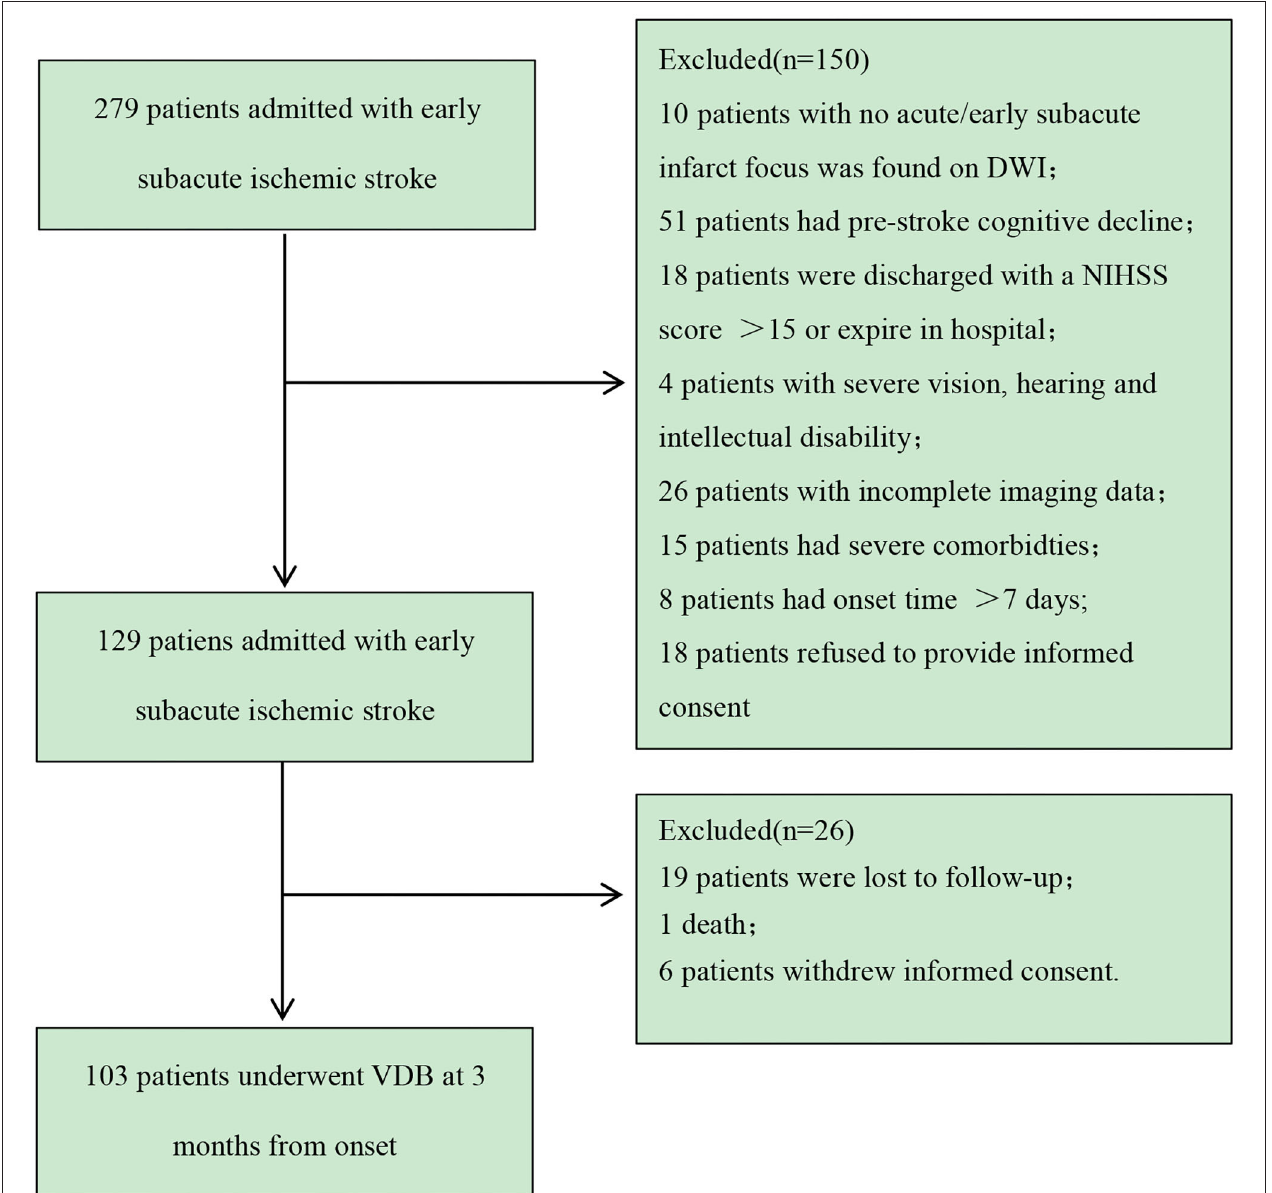
FIGURE 2 | Patient recruitment flowchart. VDB, modified version of the Vascular Dementia Battery; TIA, transient ischemic attack; NIHSS, National Institutes of Health Stroke Scale.